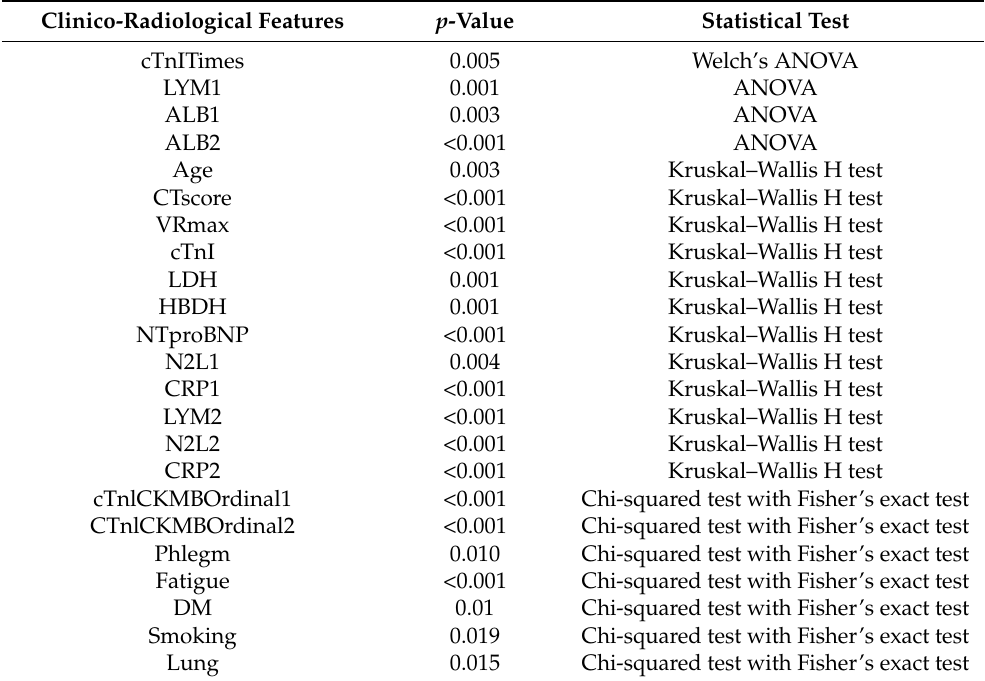
Table 2. Statistically significant ( p value < 0.05) clinico-radiological features of severity in four-type